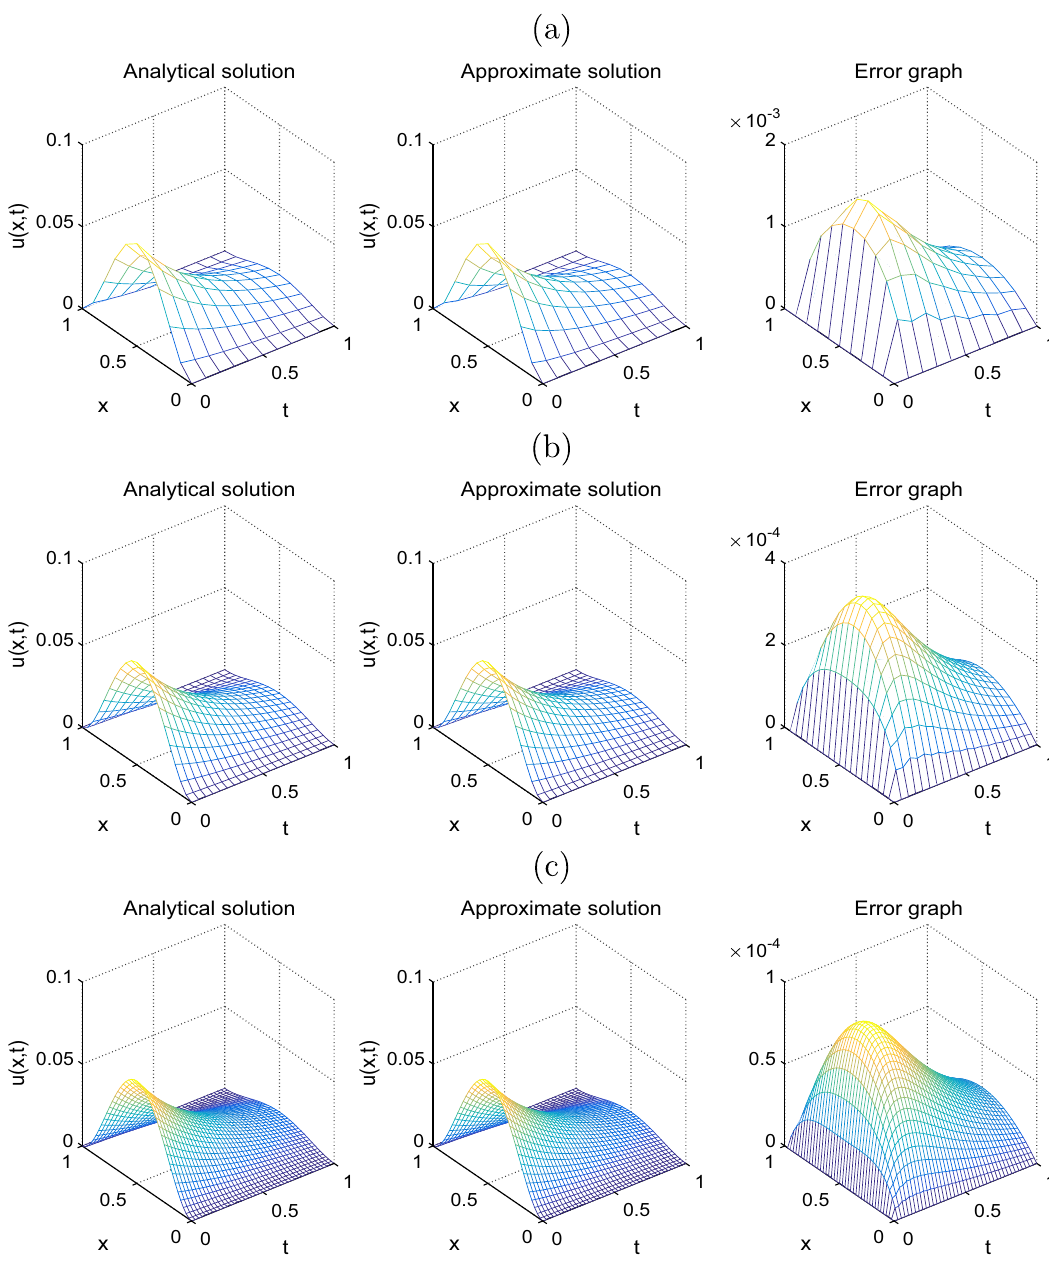
Figure 1: The exact ( 78 ) and approximate ( ) u x t , with absolute errors for = M N : ( a ) 10, ( b ) 20, and ( c ) 40, for the direct